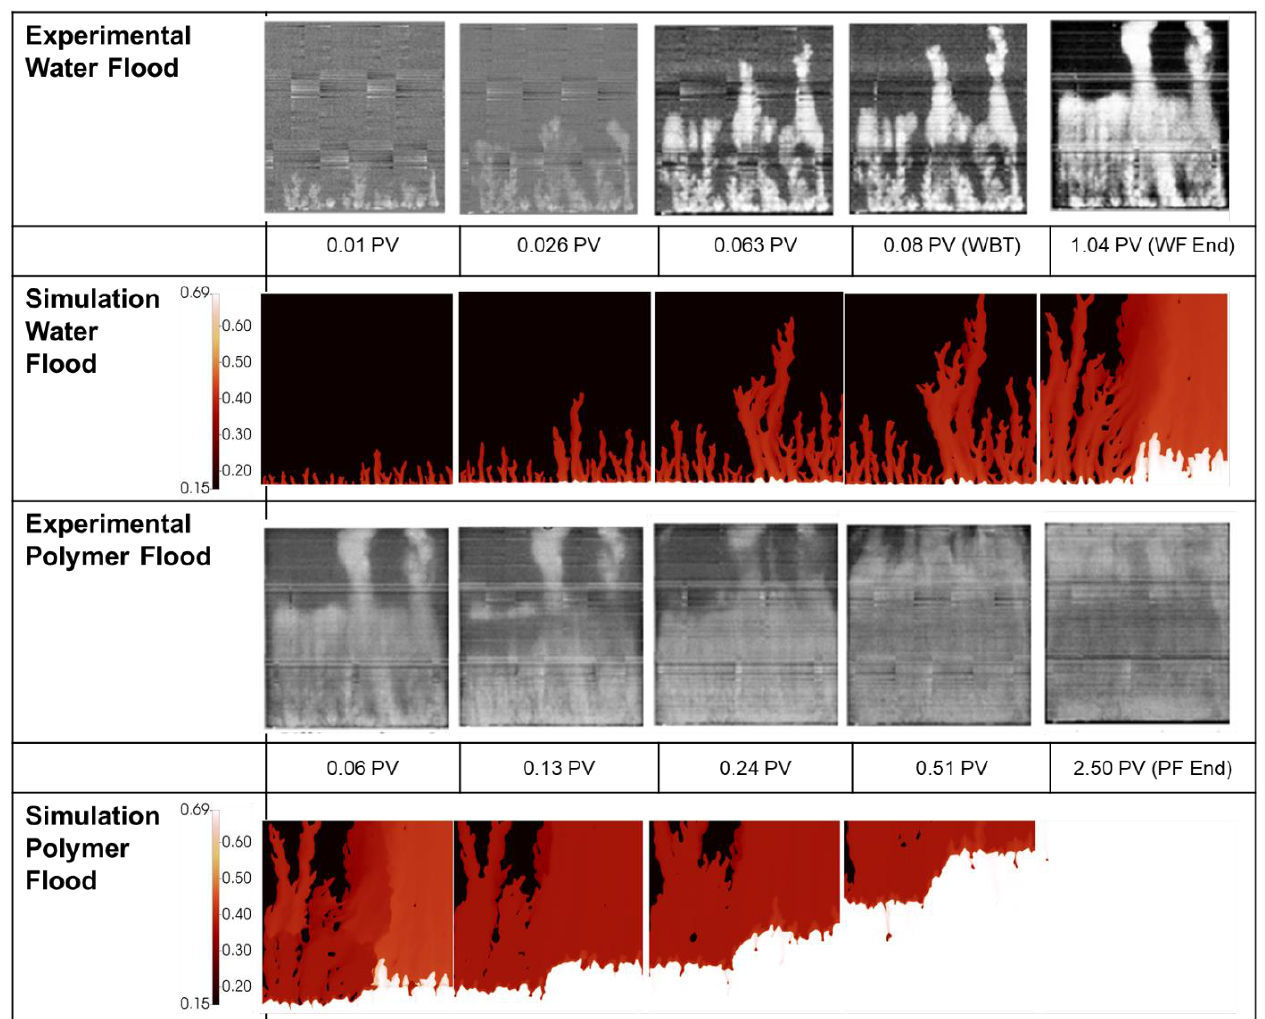
Figure 14. Experimental vs. simulated finger patterns during displacement of 616 mPa.s oil. Analysis of the 616 mPa . s case : During water flooding, the simulated finger patterns for